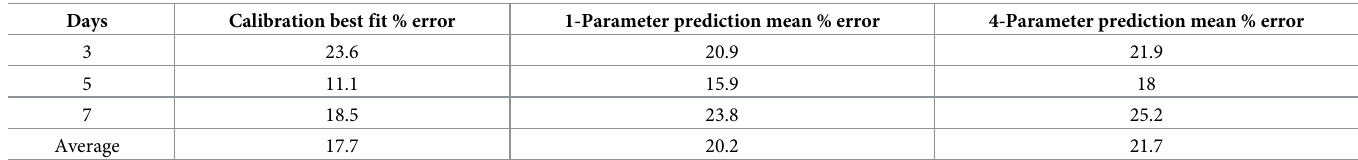
Table 4. Error in calibration and prediction of vascular density. We compare the relative error in the calibration best fit, the 1-parameter, and 4-parameter prediction cases.